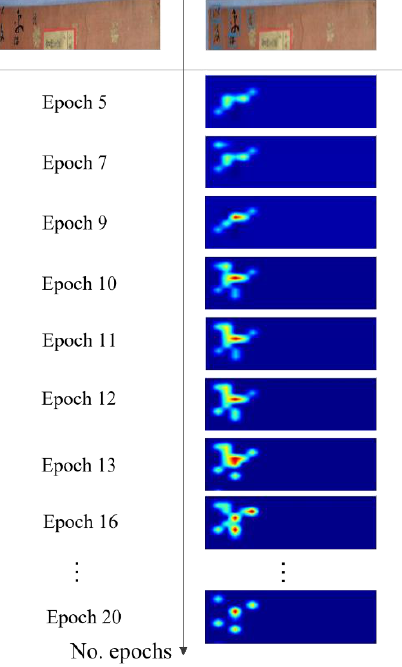
Table 2. Comparisons of different regression methods with respect to bounding box corners.